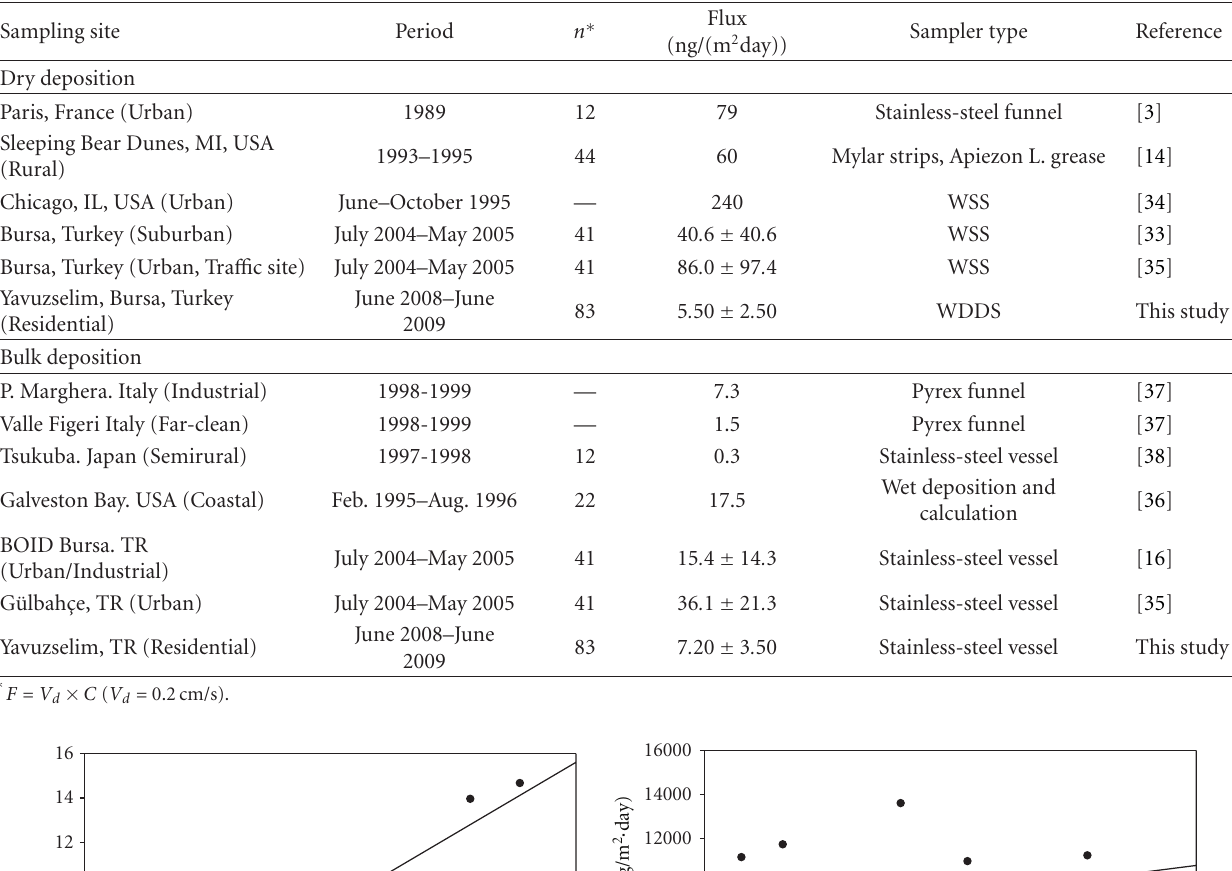
Table 4: Dry and bulk deposition flux values obtained at di ff erent sampling site.